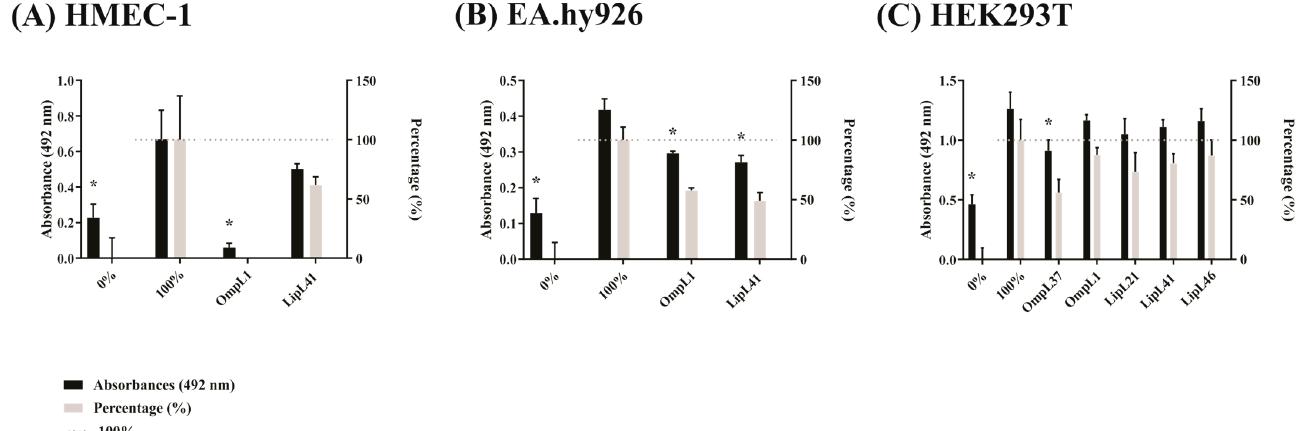
Figure 6. The interaction of leptospires with mammalian cells was affected by adding recombinant proteins. Binding of bacteria was assessed in 96-well plate with cell monolayers (10 5 cells/well). Cells were incubated with recombinant proteins in saturation concentration with 1 µM aprotinin for 1 h. Wells without the addition of proteins was used for the controls. Leptospires (10 7 leptospires/well, MOI 100) were incubated for 2 h. Wells without and with addition of leptospires were used as controls. Samples were incubated with anti-LipL32 produced in mouse, and the detection was performed with anti-mouse IgG-peroxidase. Values were represented by percentage considering the wells without and with the addition of leptospires as 0 and 100% of adhesion, respectively. The binding of the bacteria was compared to the 100% control by the two-tailed t -test ( p < 0.05) showed by *. ( A): HMEC-1, ( B ): EA.hy926, ( C ): HEK293T.